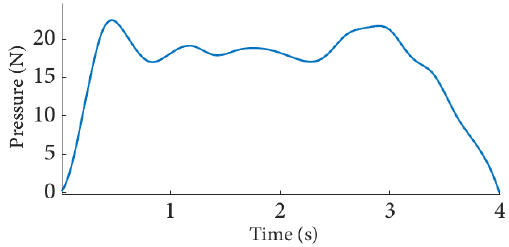
Figure 2. Curve of pressure change under grabbing process.